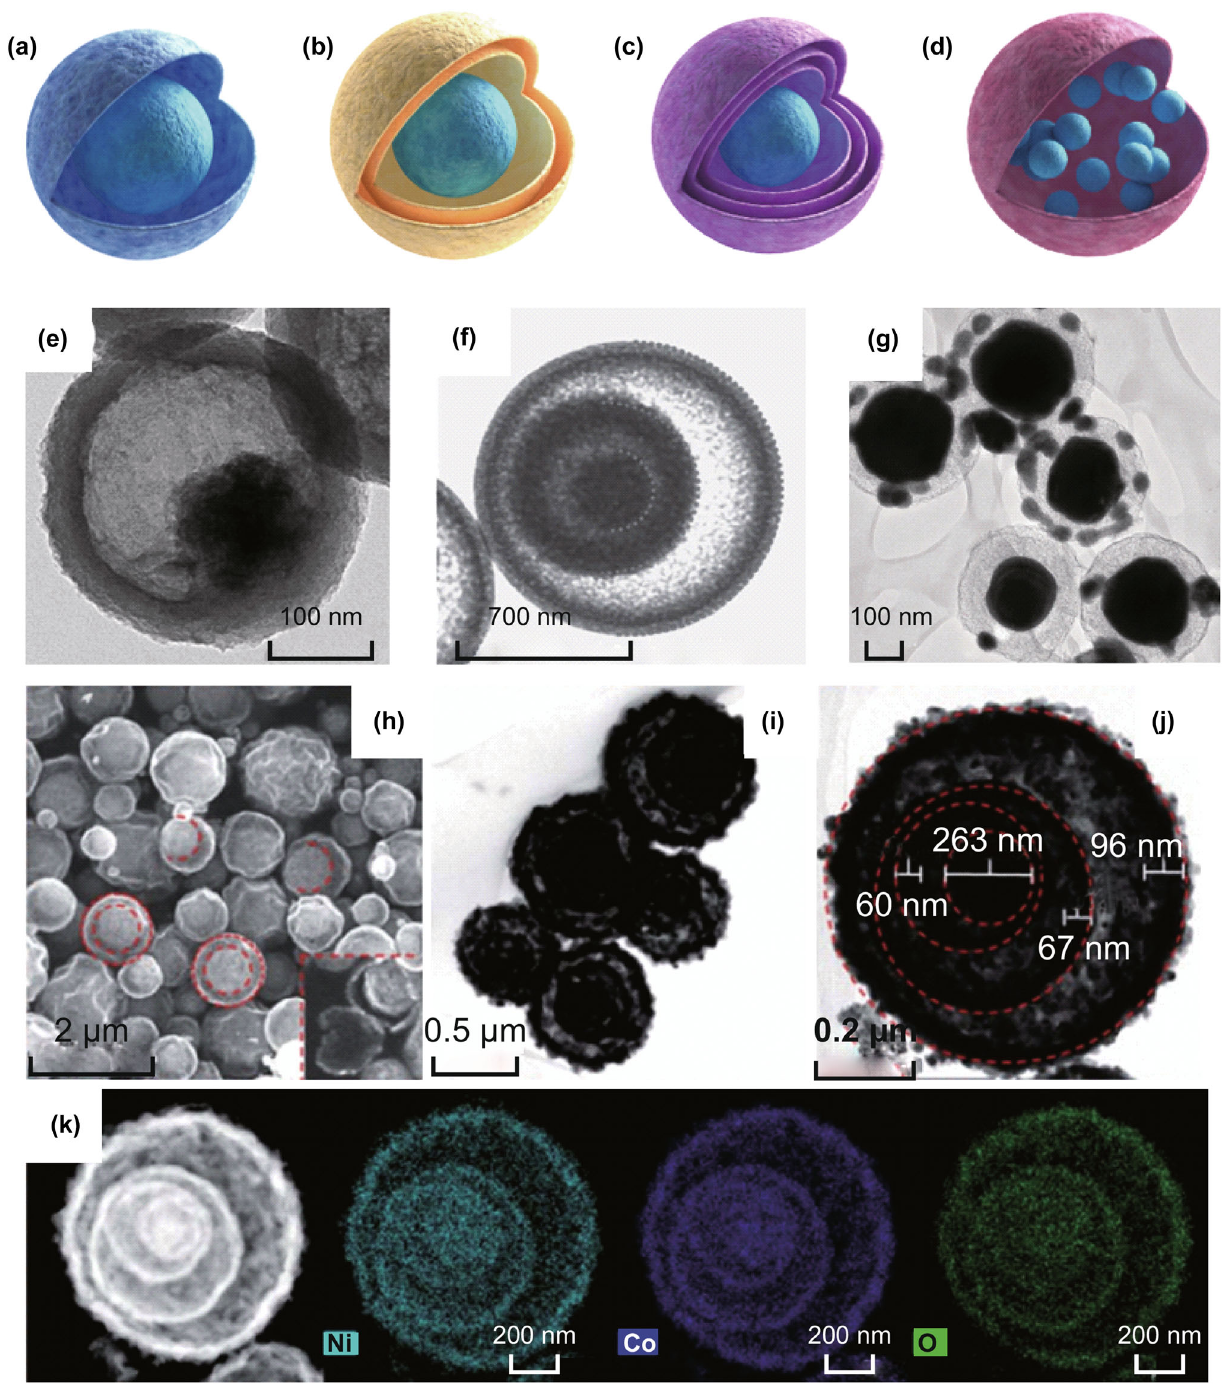
Fig. 1 Graphical illustration of yolk–shell structure: a single shell with single yolk, b double shells with a single yolk, c multiple shells with a single yolk, and d single shell with multiple yolks. Reprinted with permission from Refs. [21, 55, 133]. TEM images of: e single shell with single yolk, f double shells with single yolk, and g single shell with multiple yolks. h SEM, i TEM, j HRTEM and k element mapping images of triple shells with single yolk. Reprinted with permission from Refs. [58, 60, 62, sizes. Ni, Co and O elements were detected and evenly distributed in dot-mapping images of Fig. 1k. The four red dashed cycles in Fig. 1j show the morphology of three